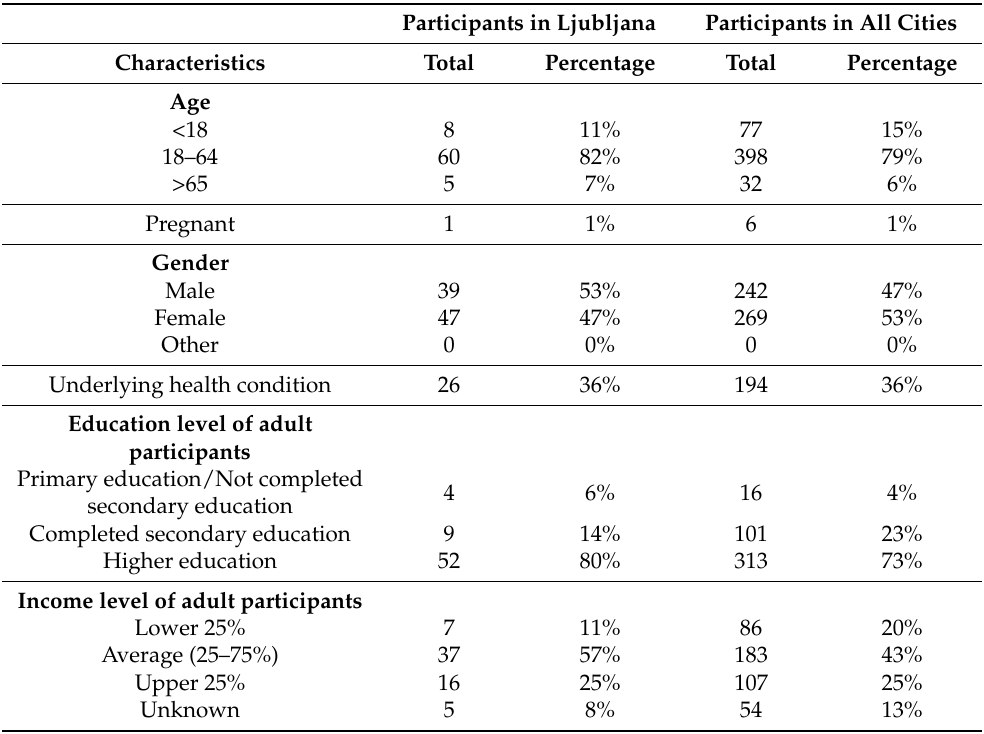
Table 1. Participant